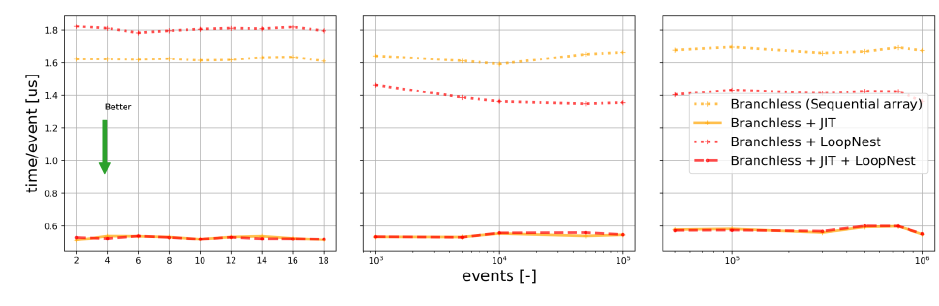
Fig. 6. Speedup in inference by adopting the JIT and the loop nest